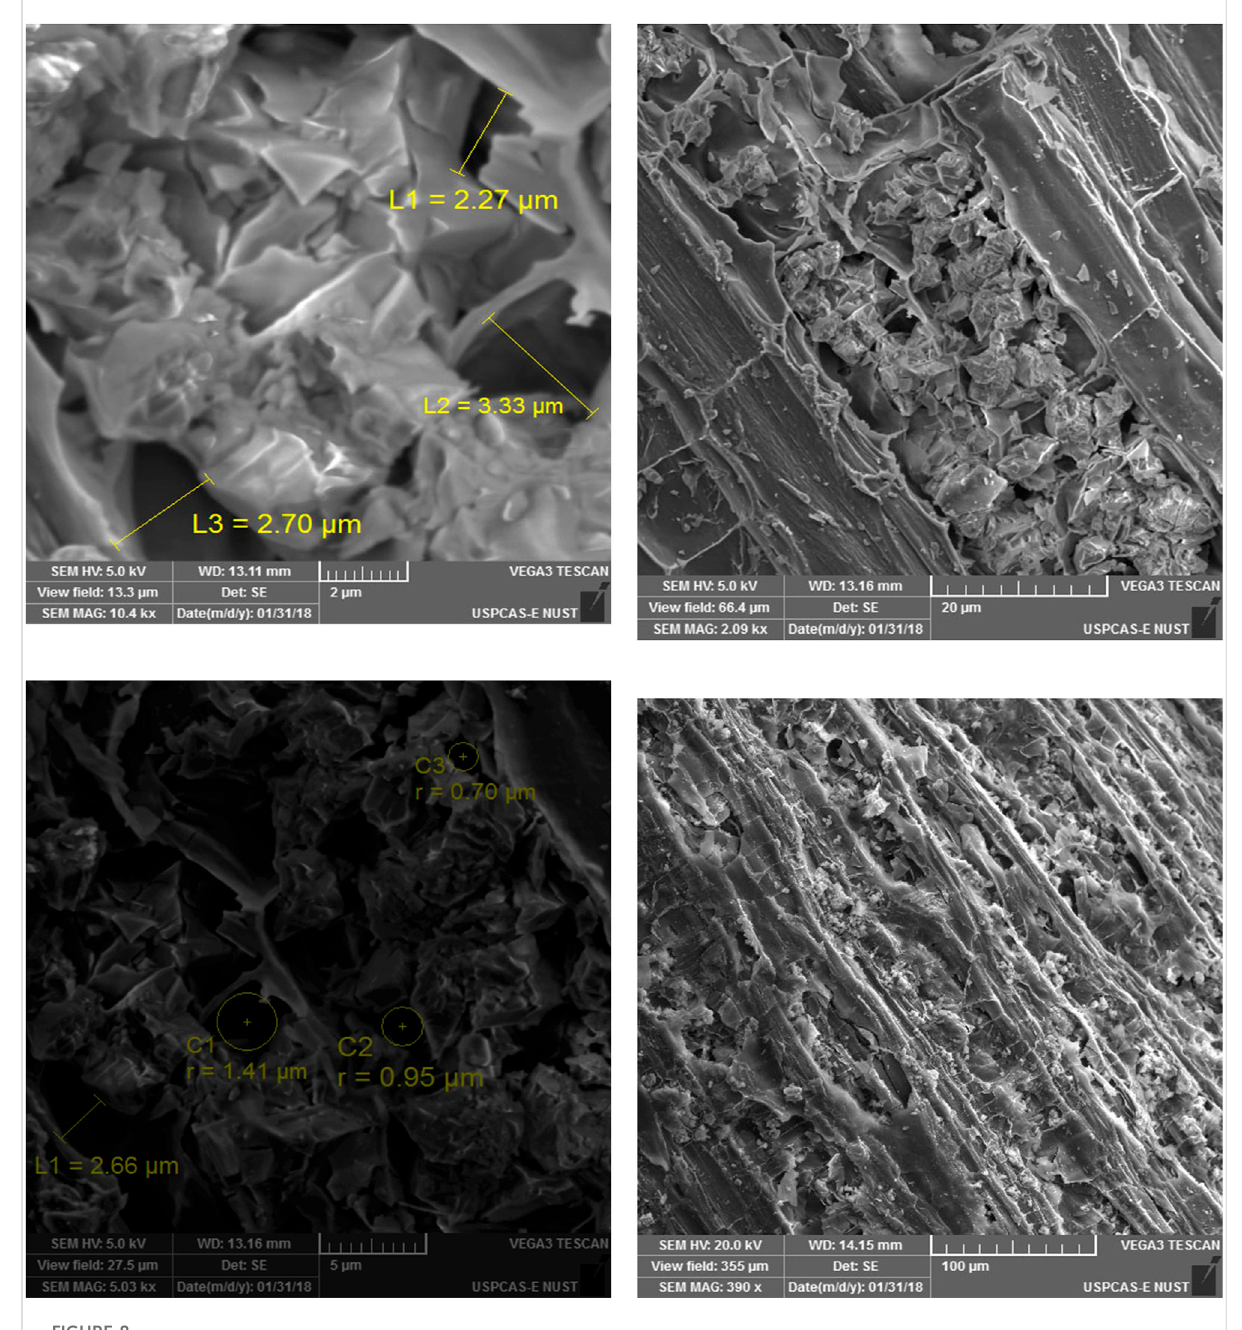
FIGURE 8 Scanning Electron Microscopy (SEM) images of Cannabis sativa biochar at different magni fi cations.